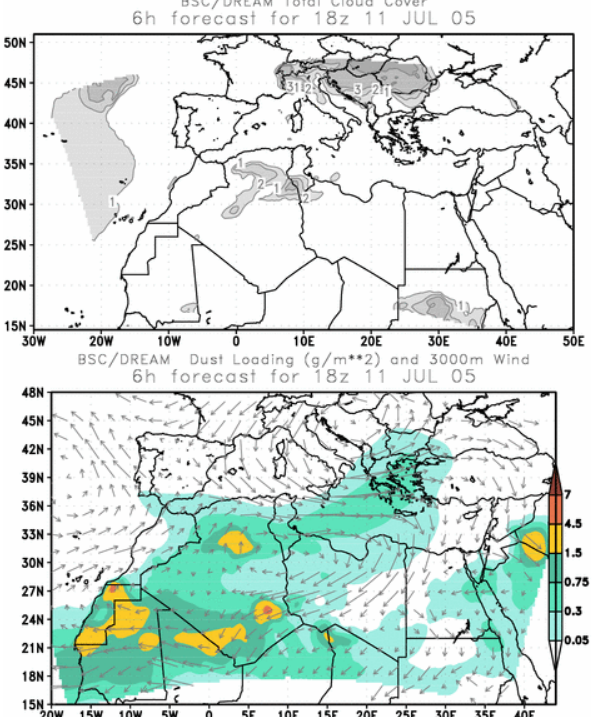
Fig. 3. Total cloud cover (relative units), dust load (g/m 2 ) and wind vectors (at 3000m) over Mediterranean on 11 of July 2005 at 18:00UTC, when dust aerosol was present over Athens, as esti- mated by the DREAM model.